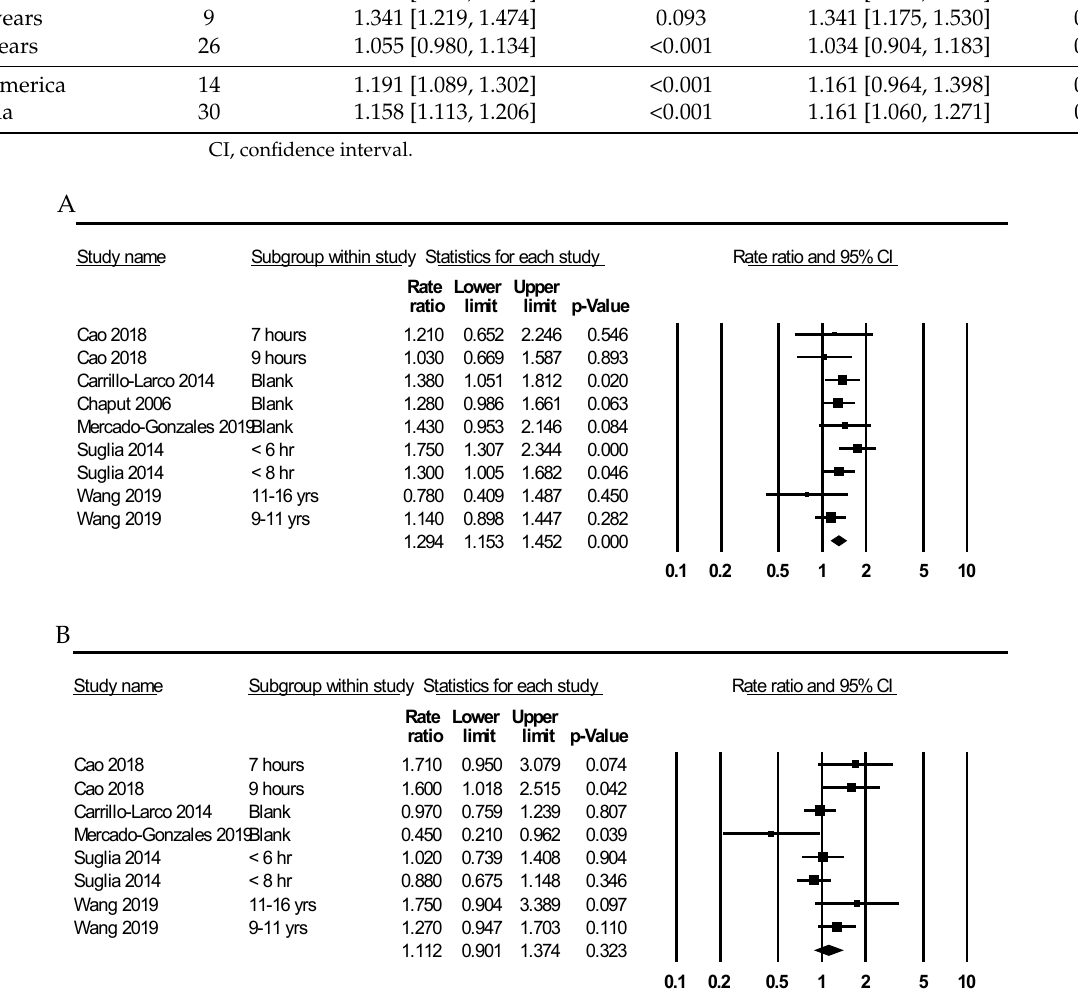
Figure 2. Forest plots of odds ratios for obesity/overweight according to short sleep duration in boys ( A ) and girls ( B ).